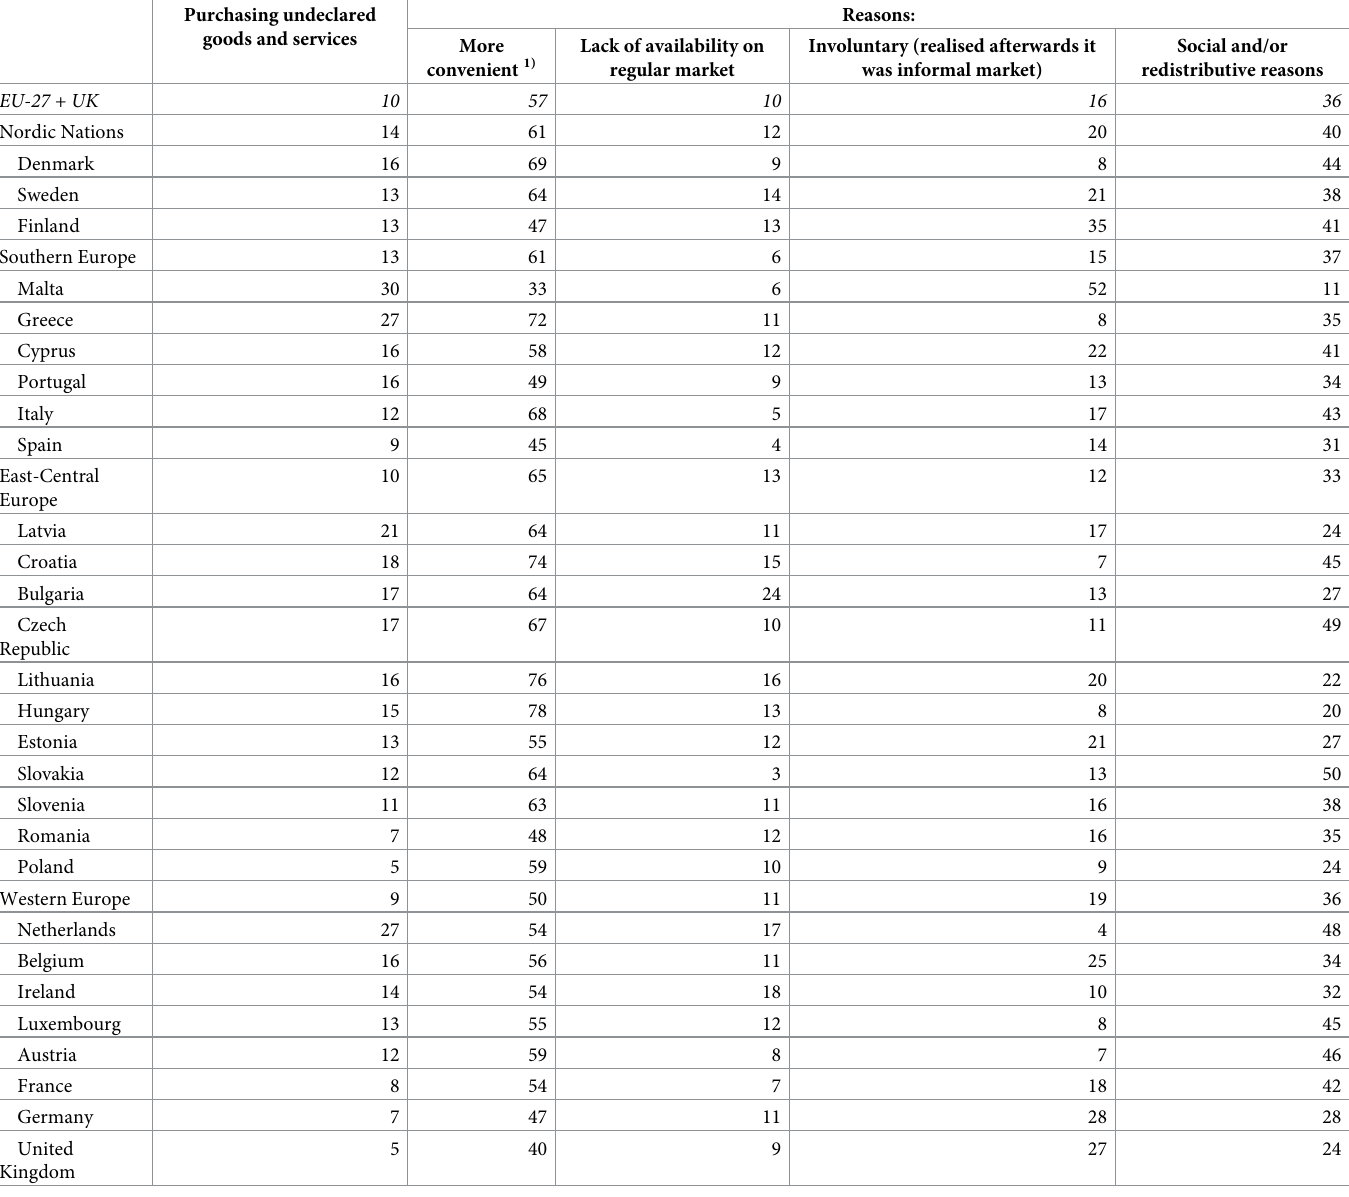
Table 2. Reasons for which the European consumers make purchases from the informal economy: By country (%; N = 27,565). Purchasing undeclared goods and